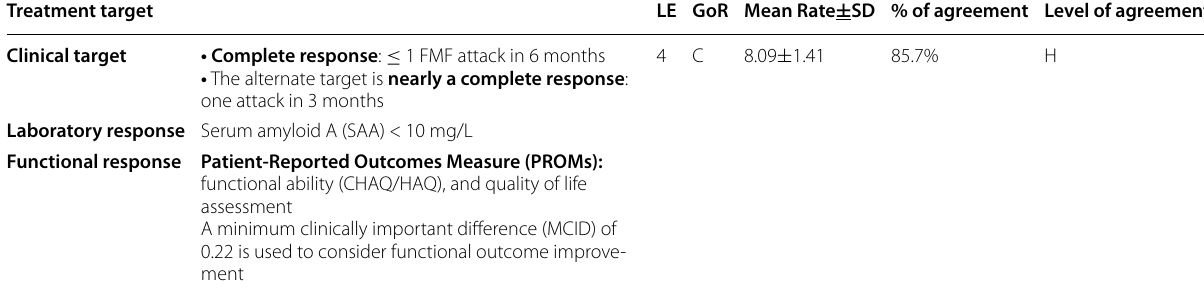
LE level of evidence, GoR Grade of Recommendation, FMF familial Mediterranean fever, CHAQ Child Health Assessment Questionnaire, SAA serum amyloid A, MCID minimum clinically important difference, PROMs Patient-Reported Outcomes Measure